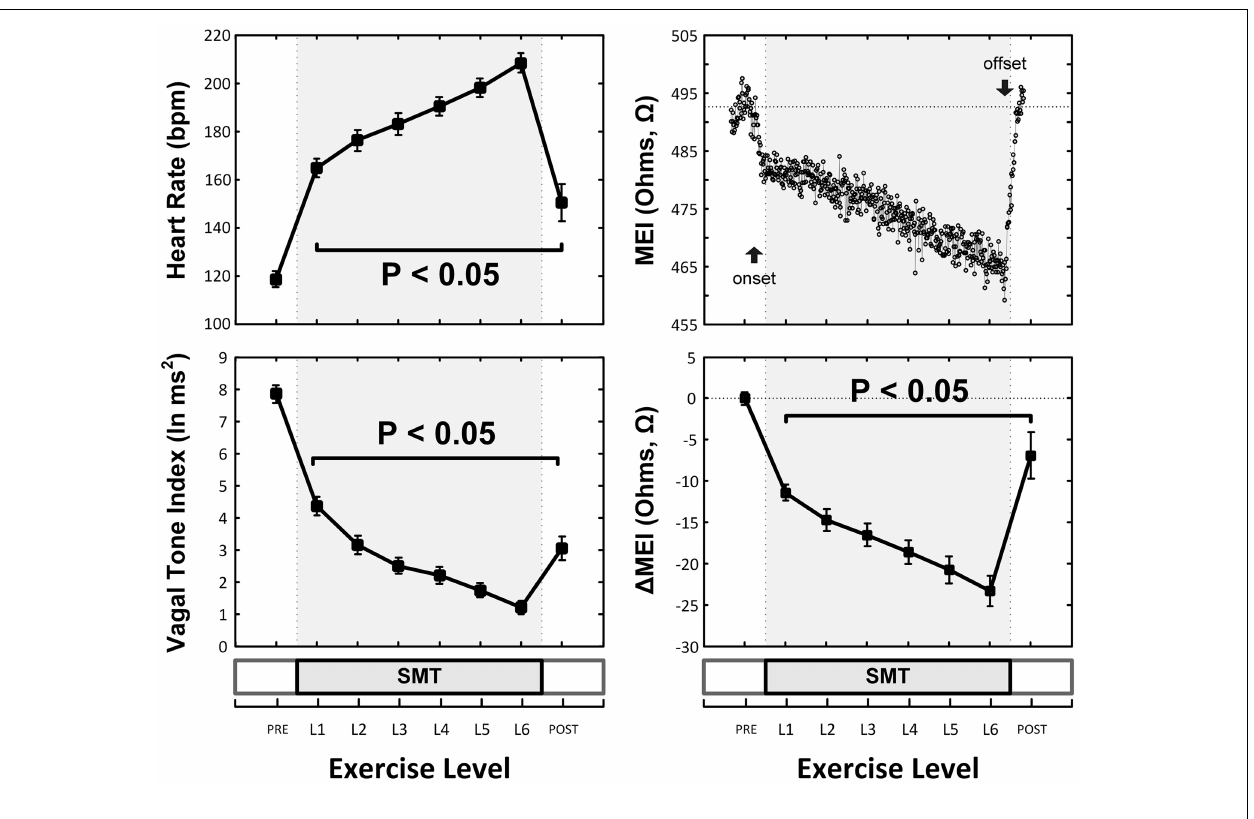
FIGURE 2 | Exercise-Induced changes in the heart-rate (HR, top-left) and ECG-derived vagal-tone index (bottom-left) and well as in the myocardial electrical impedance (MEI, bottom-right with representative